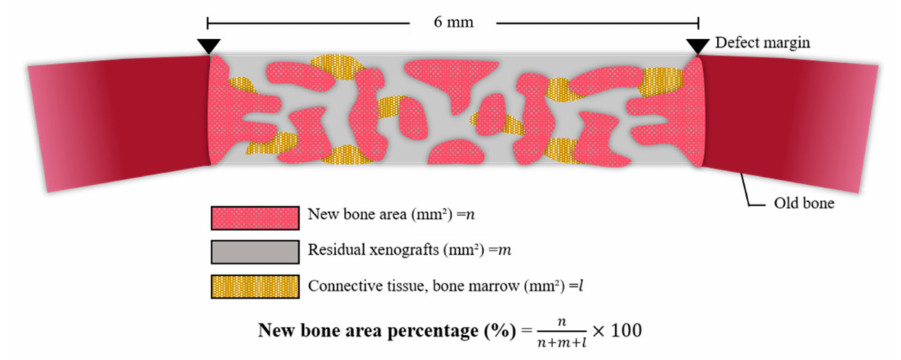
Figure 14. Schematic diagram for histometric